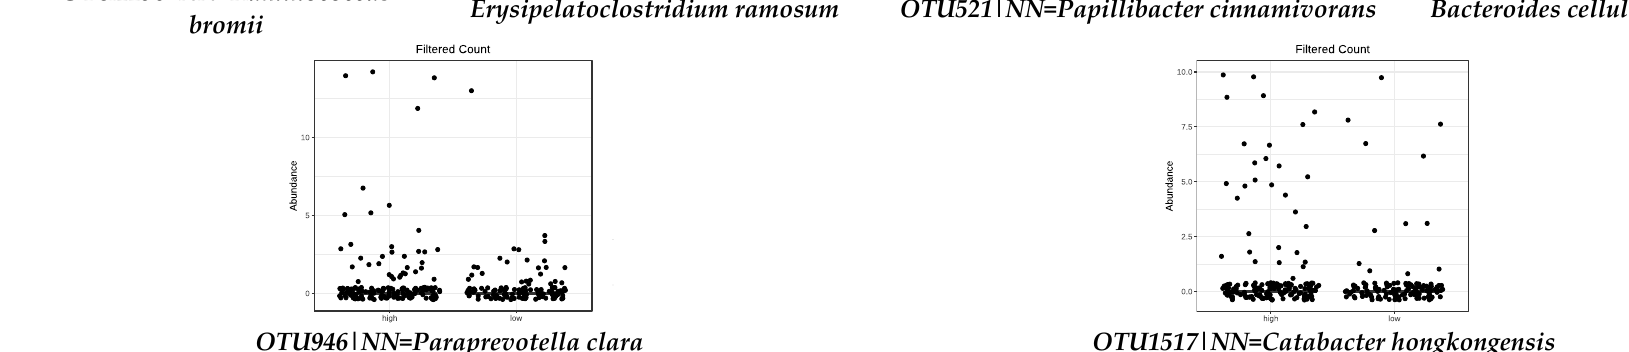
Figure 1. Bacterial species that were significantly more abundant in the group with high adherence to MD (FDR < 0.05) by metagenomeSeq test. Red boxes represent participants with a higher adherence to the MD and blue boxes low adherence.